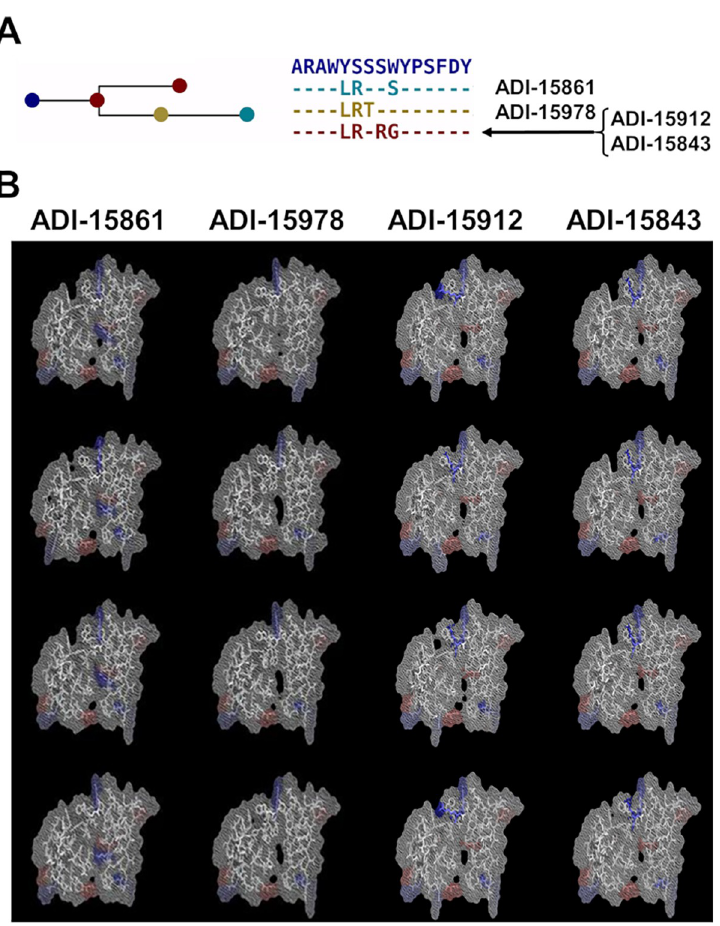
Fig 4. Set of four antibodies associated with one family lineage. (A) The graph highlights the amino acid substitutions in the heavy chain CDR3 region of the Abs with respect to the germline gene. Abs ADI-15912 and ADI- 15843 share the same CDR3 sequence. (B) Each column shows three fingerprints for each Ab of the family showing how the amino acid substitutions listed in (A), and conformational changes in the models affect the